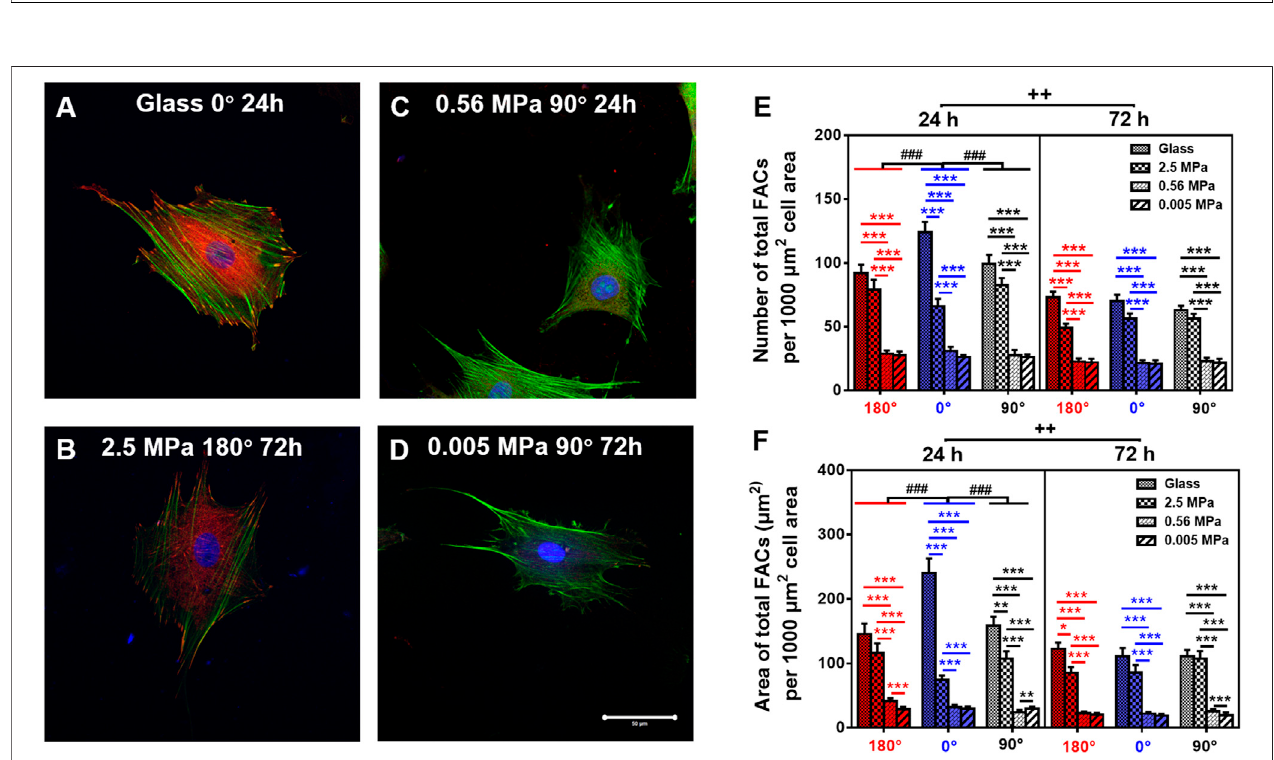
FIGURE 5 | Comparison of focal adhesion complex (FAC) (green, actin; red, vinculin) formation. (A – D) Typical images for cells placed onto glass (A) 0 ° , 24 h, 2.5 MPa, (B) 180 ° , 72 h, 0.56 MPa, (C) , 90 ° , 24 h, or 0.005 MPa, (D) , 90 ° , 72 h poly-dimethylsiloxane. Bar = 50 µm. (E,F) The number (E) and area (F) of total FACs (normalized per 1,000 μ m 2 cell area) for cells onto the four different stiffness of substrate in three orientations were presented as mean ± SE of ~45 cells from three repeated experiments at 24or 72 h. *, **,or ***, t -test, p < 0.05, 0.01, or 0.001; ### ,two-way ANOVA test fordifferentgroup with different time withcell orientation, p < 0.001; ++ , three-way ANOVA test for differences among stiffness, orientation, and duration, p < 0.01.